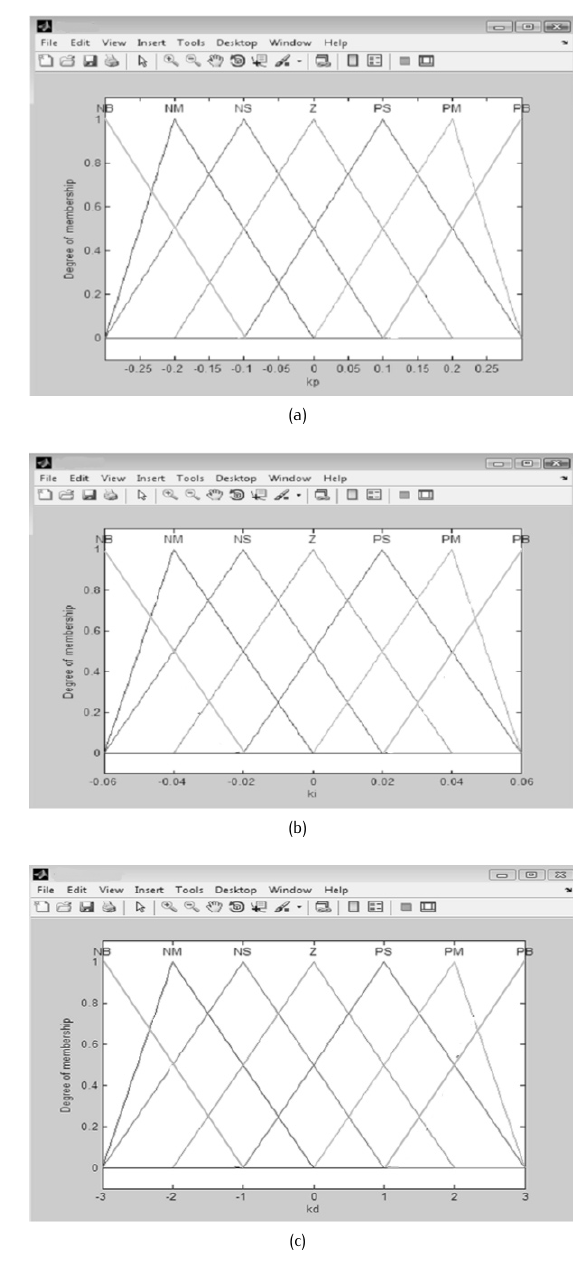
Figure 3. Membership functions for: a) k